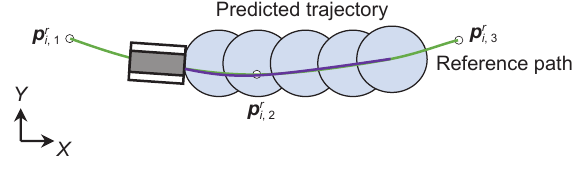
Fig. 5 Predicted trajectory based on MPCC.